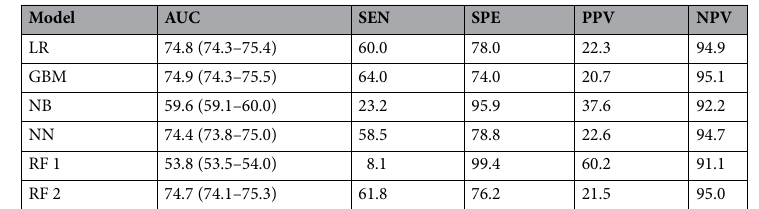
Table 2. Model performances for frequent users 3. GBM gradient boosting machine, LR logistic regression, NB naïve bayes, NN neural network, RF random forests, AUC area under the curve, SEN sensitivity, SPE specificity, PPV positive predicted value, NPV negative predicted value.